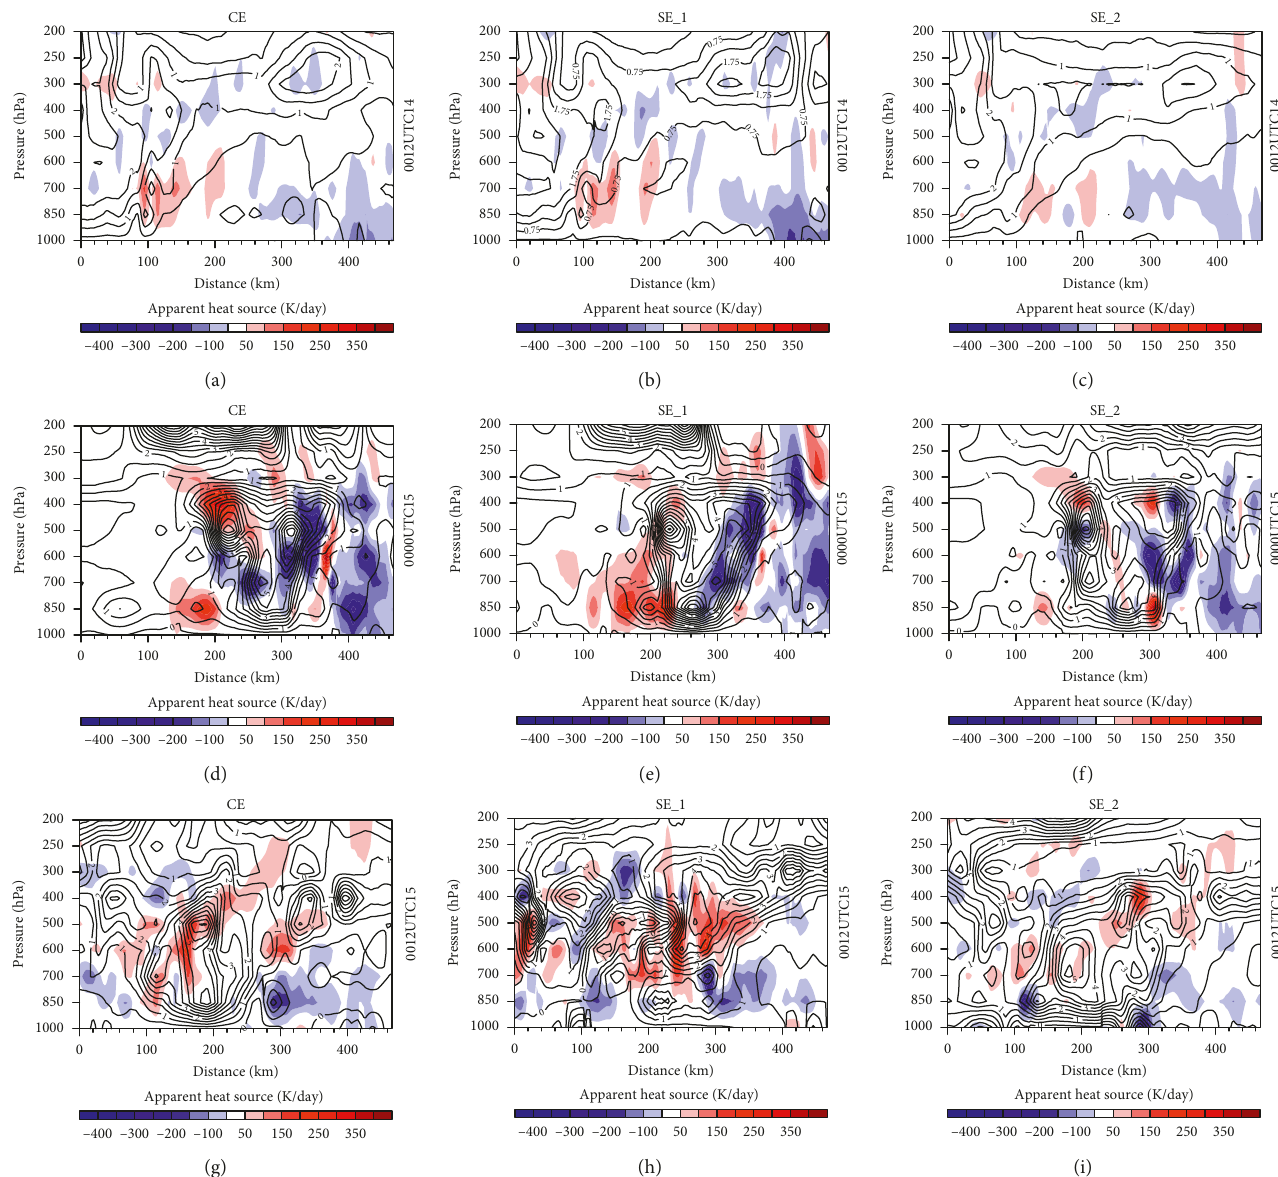
Figure 11: Vertical cross section of the apparent heat source Q 1 (shading: K/day) and potential vorticity (contour: PVU) along the track of Yagi (the red line in Figure 9(a)) in the CE and SEs. (a–c) At 1200 UTC 14 August; (d–f) at 0000 UTC 15 August; (g–i) at 1200 UTC 15 August. (a), (d), and (g) show the CE; (b), (e), and (h) show SE_1; (c), (f), and (i) show